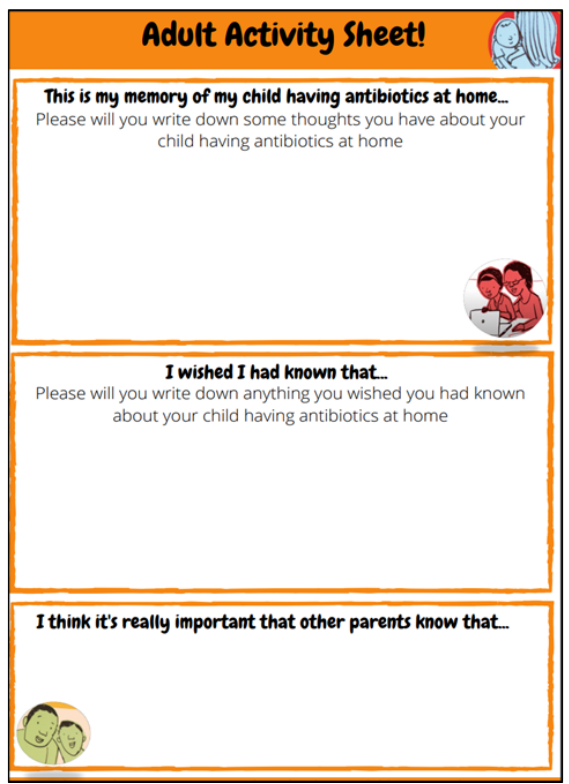
Figure 3. Adult Activity Sheet .